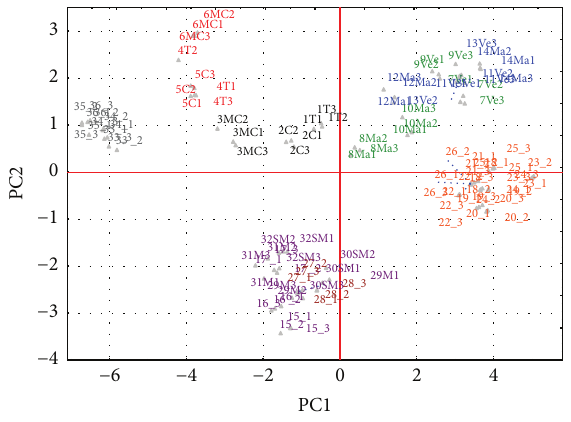
Figure 3: Score plot of PC1 versus